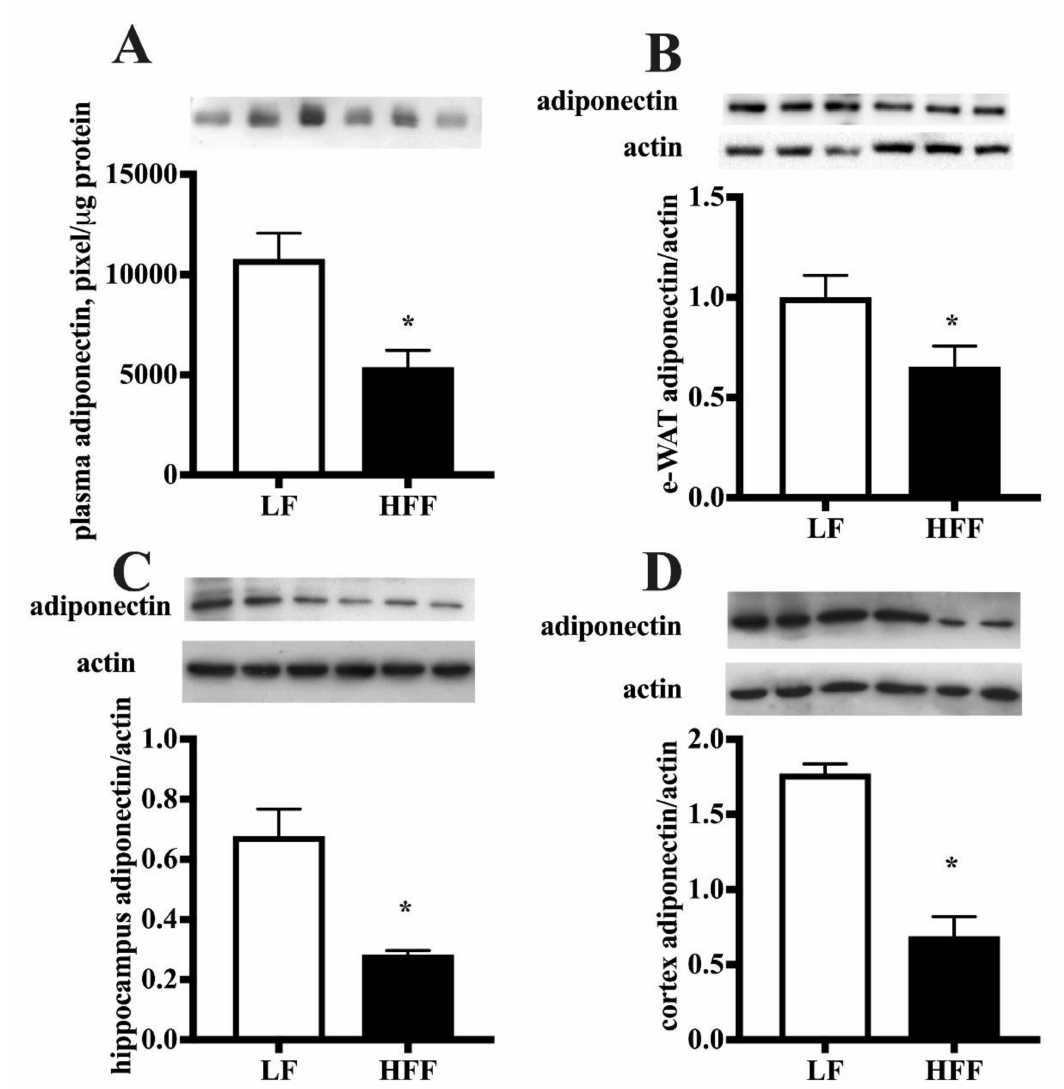
Figure 4. Protein content (with representative western blot) of adiponectin in plasma ( A ), epididymal white adipose tissue (e-WAT) ( B ), hippocampus ( C ), and frontal cortex ( D ) from middle-aged rats fed low fat (LF) or high fat-high fructose (HFF) diets for four weeks. Plasma adiponectin was detected by using 5 µ L of sample. Values are the means ± SEM of eight rats. * p < 0.05 compared to low-fat diet (two-tailed Student’s